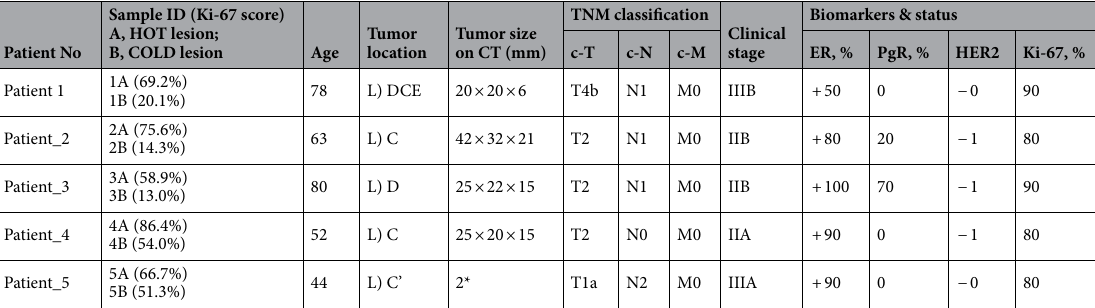
Table 1. Clinicopathological information of patients with luminal B breast cancer. CT computed tomography; HER2 human epidermal growth factor receptor 2; PgR progesterone receptor; TNM tumor-node-metastasis. *This is a case corresponding to so-called occult cancer. That is, the primary lesion was small and the metastatic lesion was found first. pT1aN2aM0: High malignant type of Grade 3, Ki-67 high in stage IIIA. Lymph node metastases were first discovered. The surgical specimen was n (5/19), but the size of the invasive cancer (infiltration diameter) was only 2 mm and 1 mm. The distance between the two was 3 mm, but lymphatic invasion was